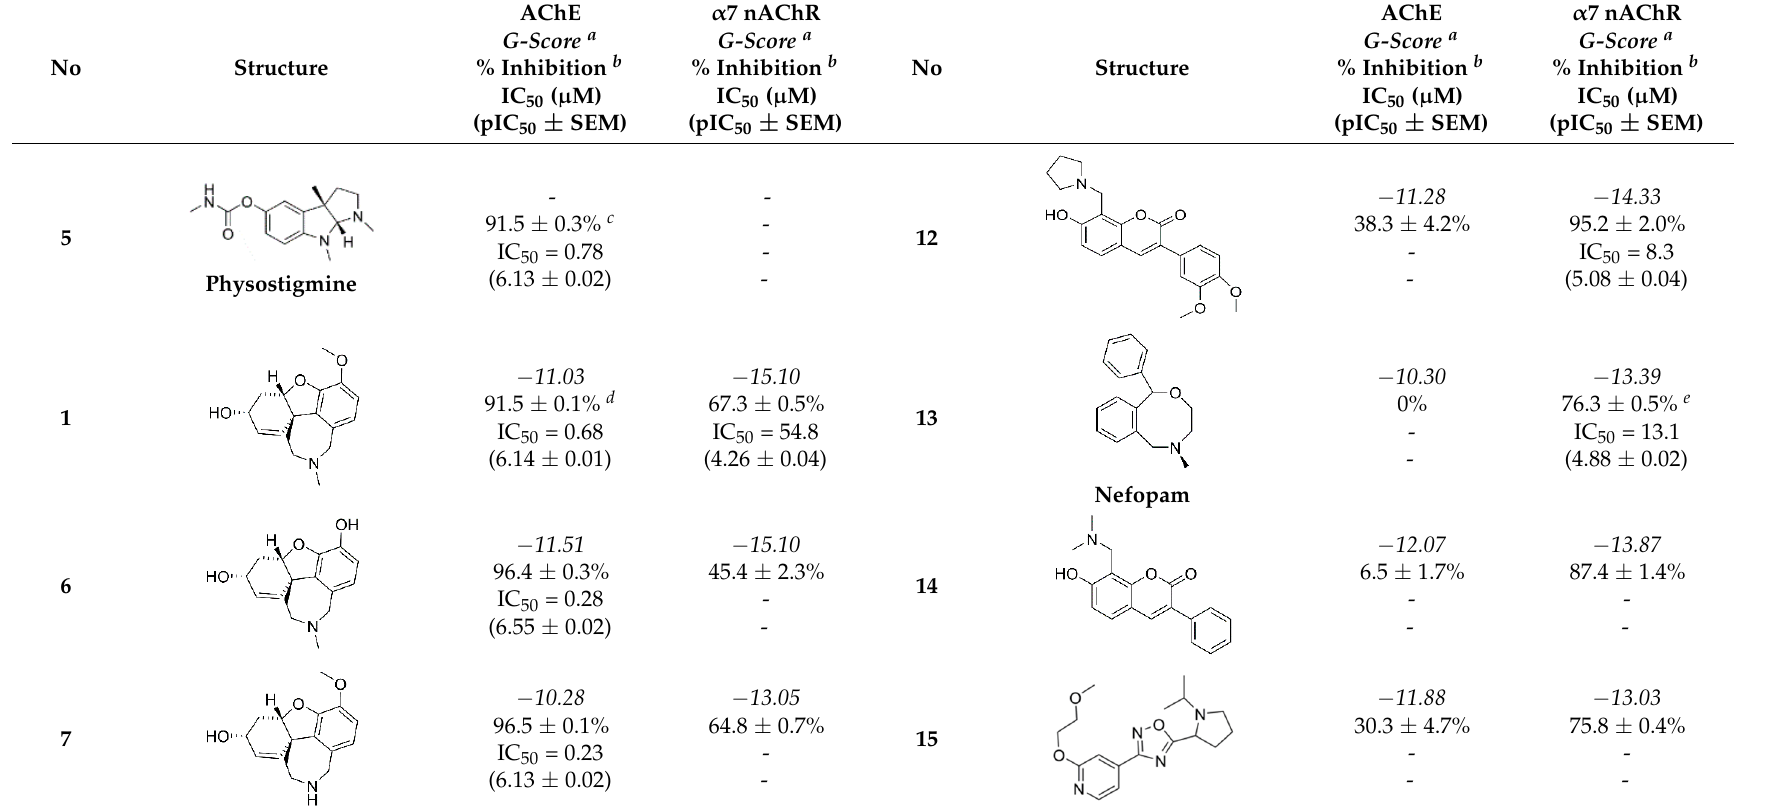
Table 1. Structures and corresponding docking scores and in vitro activities of selected hits and reference compounds. All compounds except references galantamine and physostigmine were initially evaluated at 100 µ M. For compounds exceeding 70% inhibition at the AChE and 90% at the α 7 nAChR, IC 50 values were determined.